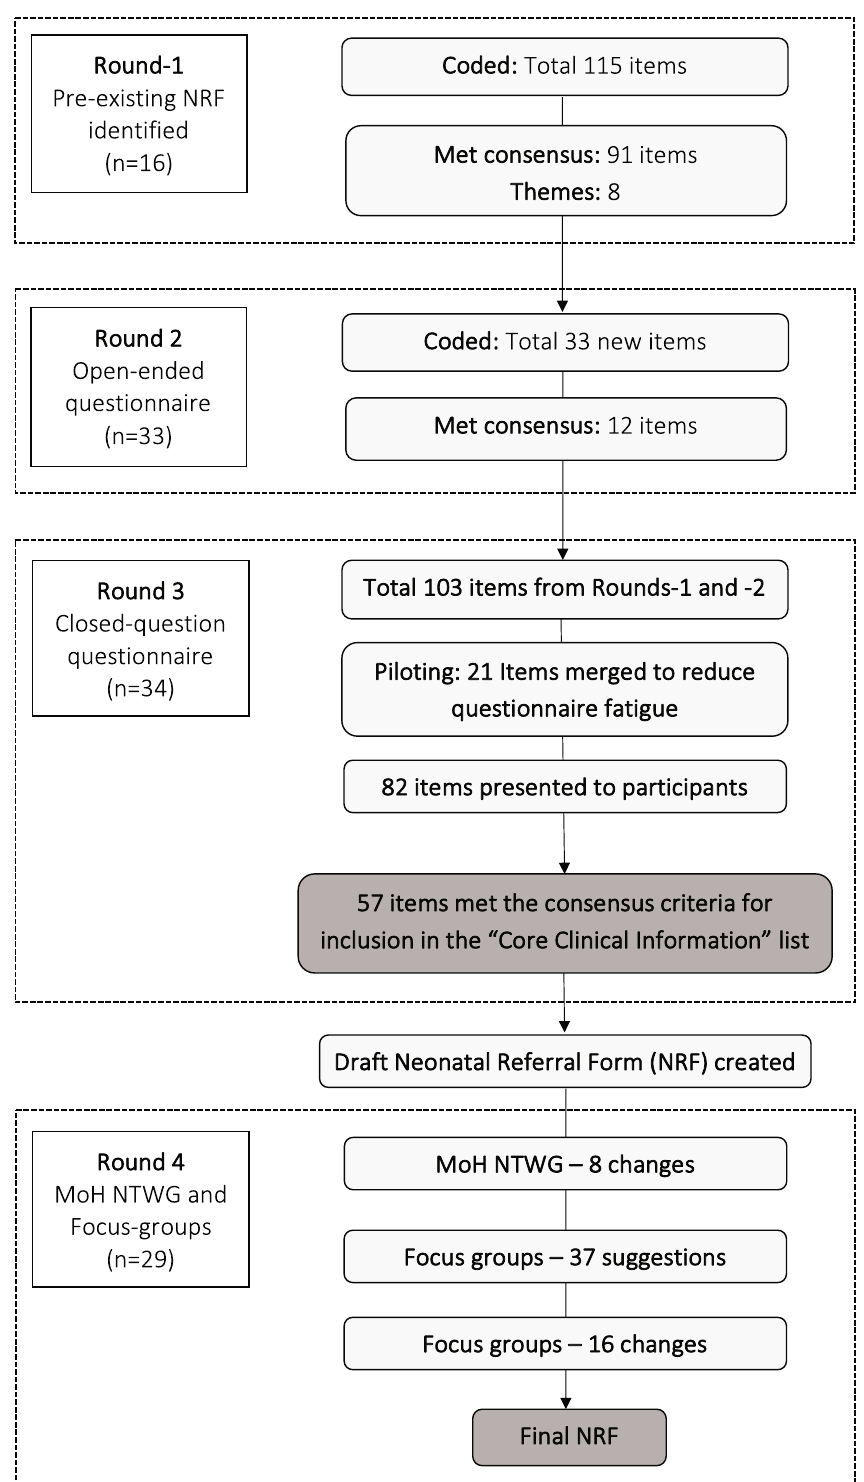
Figure 1. Delphi flow diagram. MoH NTWG, Ministry of Health Neonatal Technical Working Group; NRF, neonatal referral